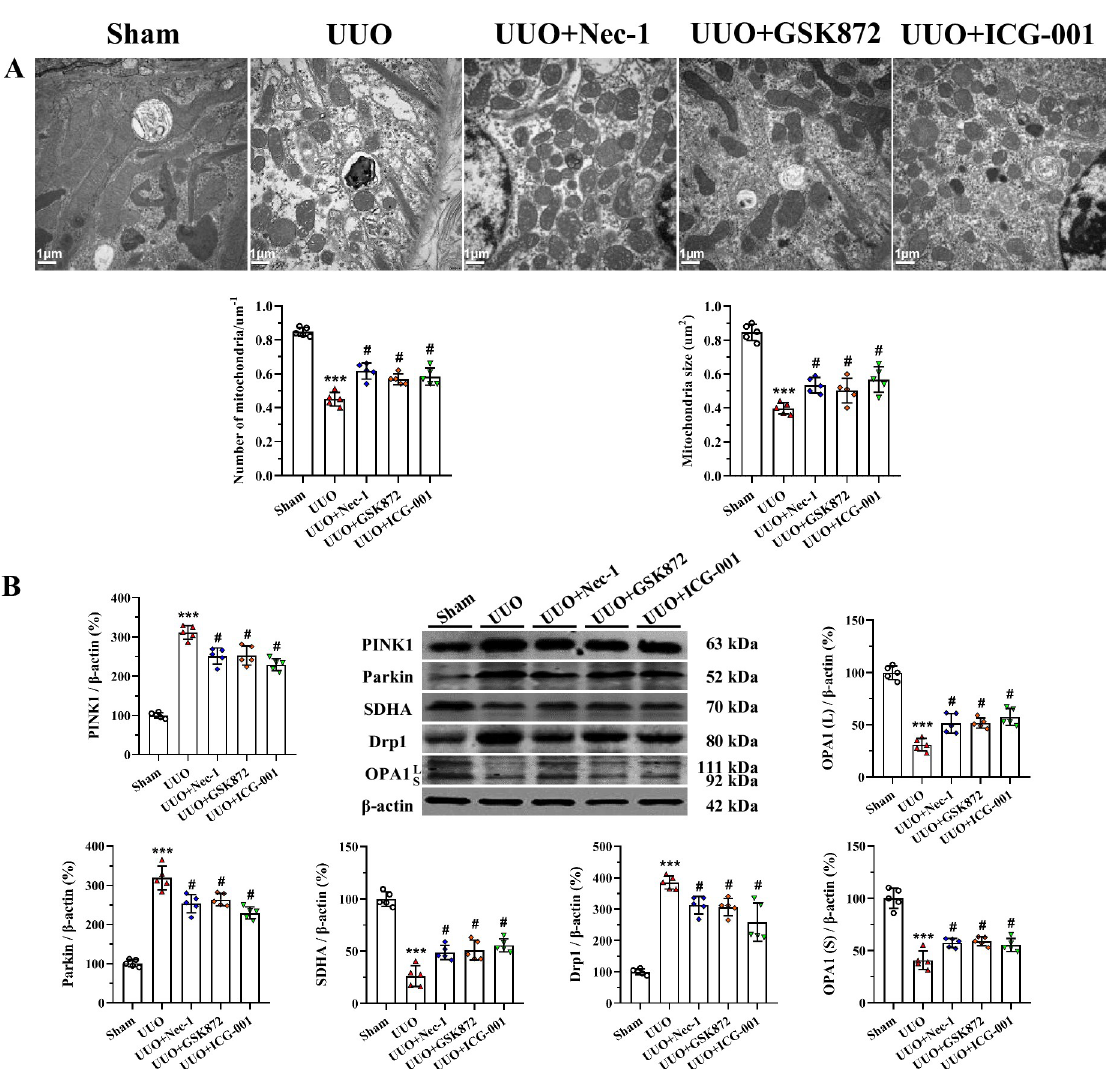
Fig 5. Representative photomicrographs of transmission electron microscopy (A) and immunoblotting analysis of mitochondria- controlling genes (B). ��� P < 0.01 vs. sham; # P < 0.05 vs. UUO.